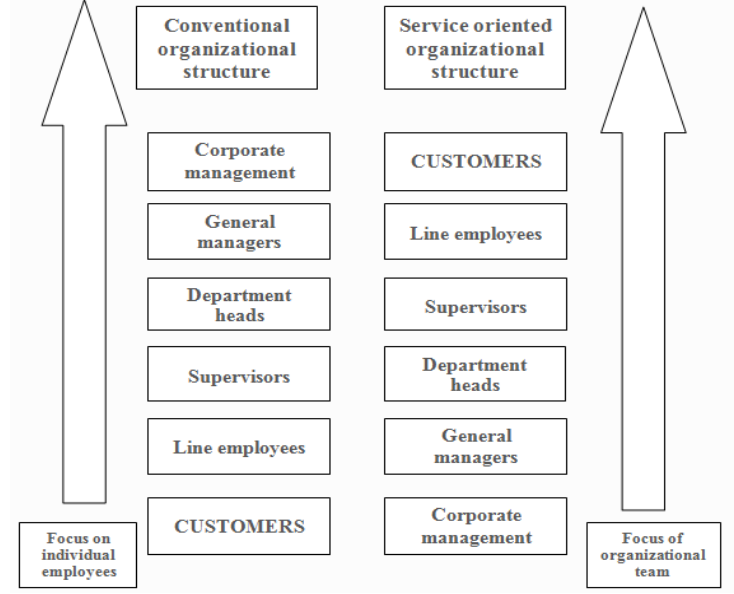
Fig. 1. Organizational focuses in internal